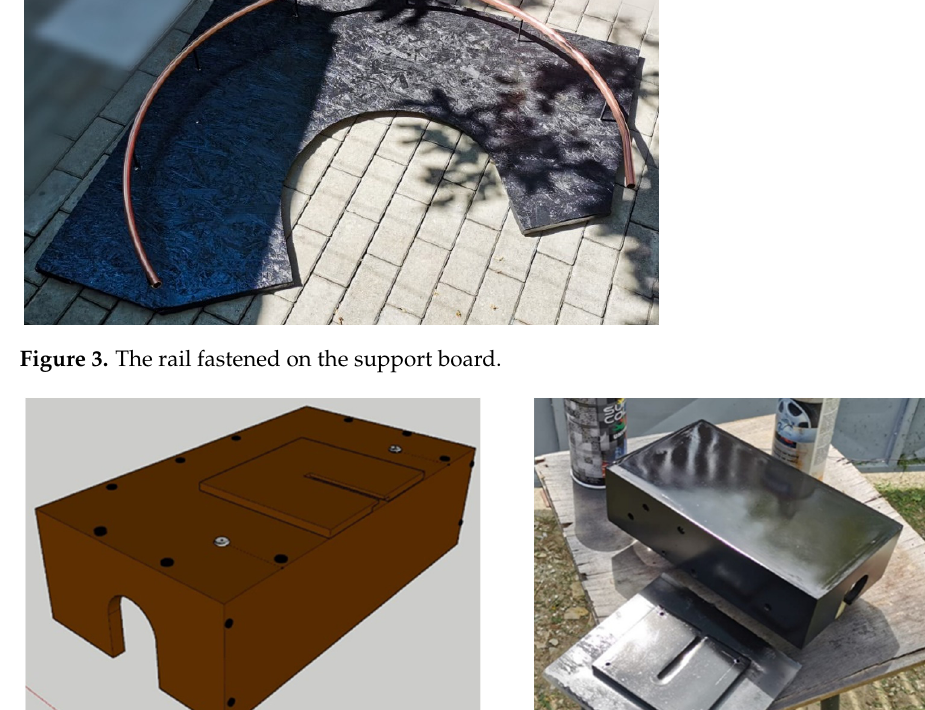
Figure 3. The rail fastened on the support board.